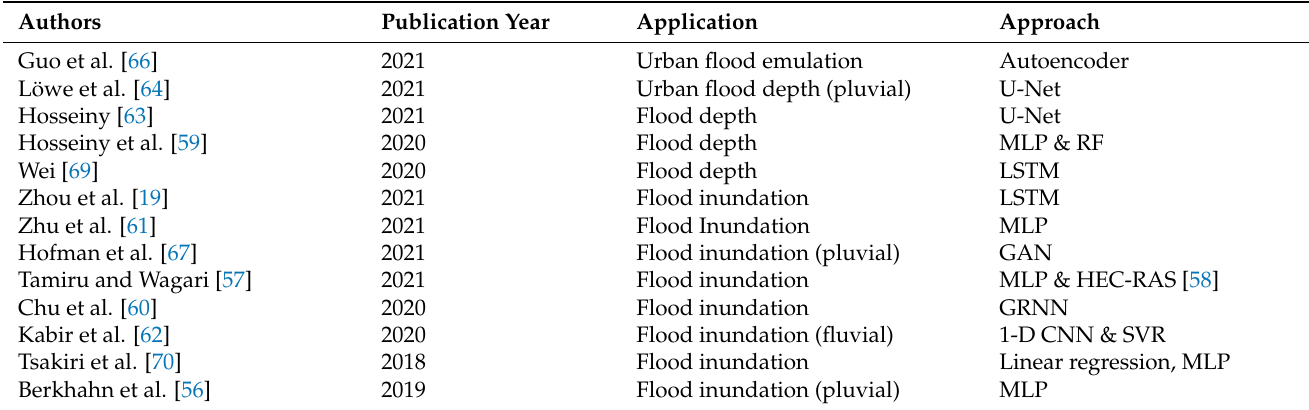
Table 3. Summary of DL approaches for flood inundation